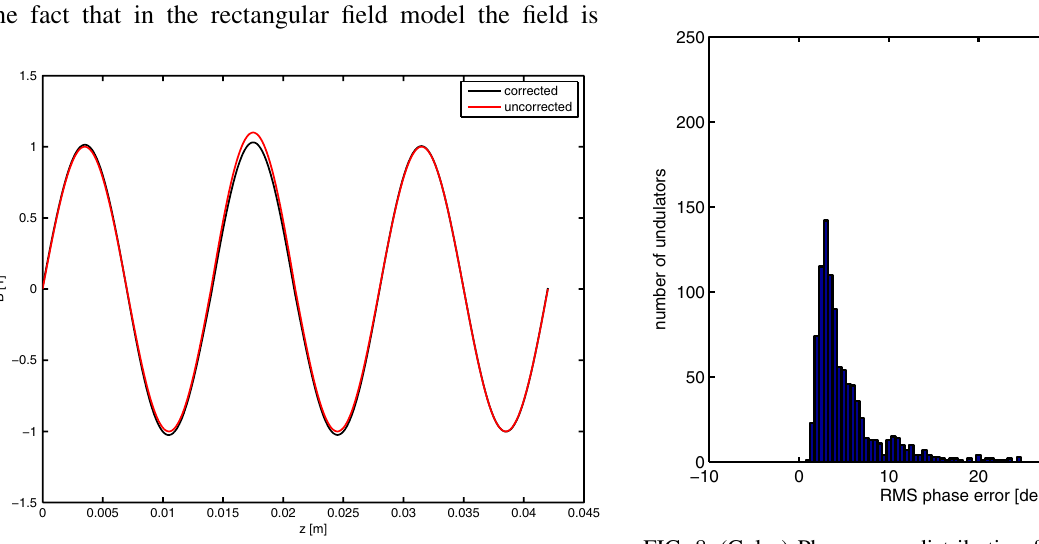
FIG. 6. (Color) Comparison of the magnetic field along the beam axis with (black) and without (red) induction shimming.